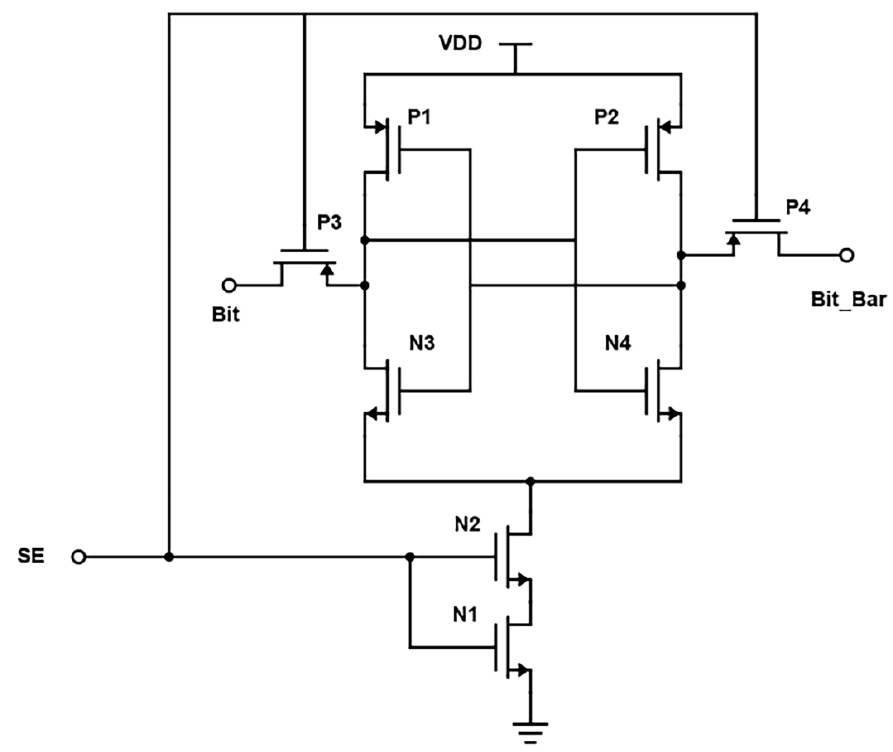
Figure 16. Commonly Cross Coupled Sense Amplifier Schematic.